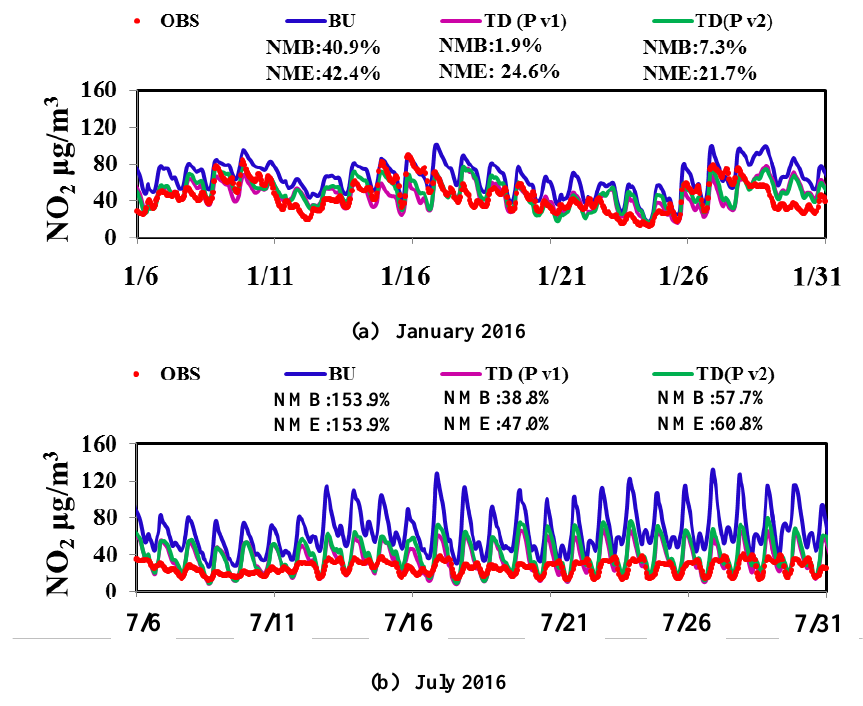
Figure 5. The observed and simulated NO 2 concentrations derived from bottom-up (BU) NO X emissions and top-down (TD) NO X emissions based on POMINO v2 (P v2) and POMINO v1 (P v1) in January and July